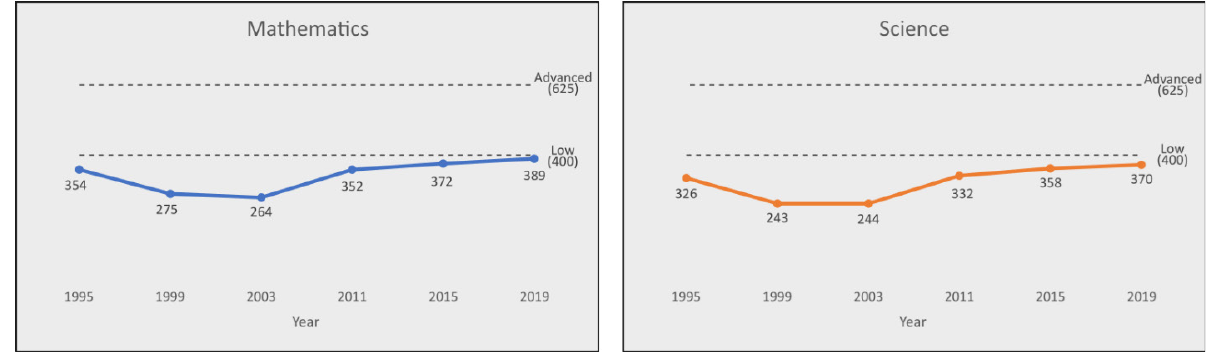
Figure 4: Trends in mathematics and science achievement for South African Grade 8/9 learners from 1995 to 2019. Data sourced from TIMMS reports.